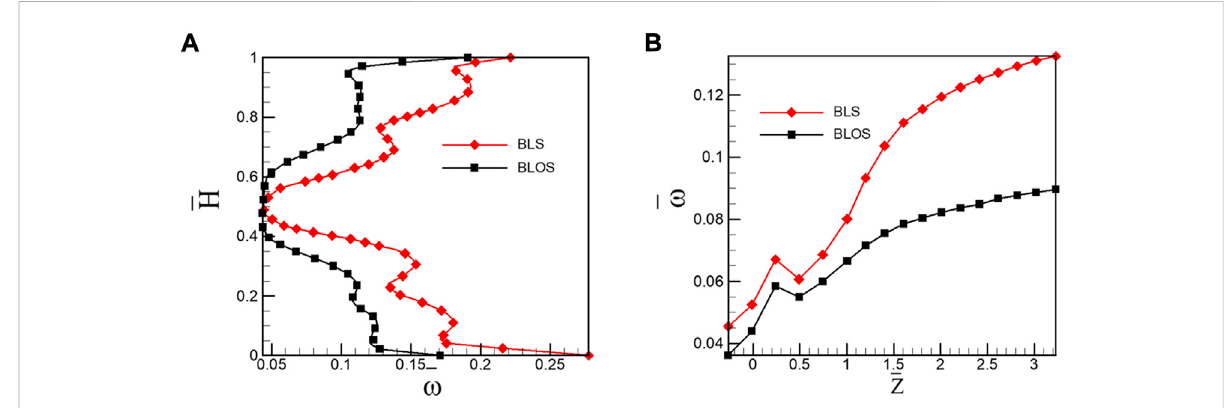
FIGURE 15 Span-wisedistributionofpitch-averagedtotalpressureloss. (A) Stream-wiseincreaseofoverallmass-averagedtotalpressurelossand (B) inthe outlet of cascade in the control with BLS and BLOS with the suction location of 0.33 (cid:1) Z